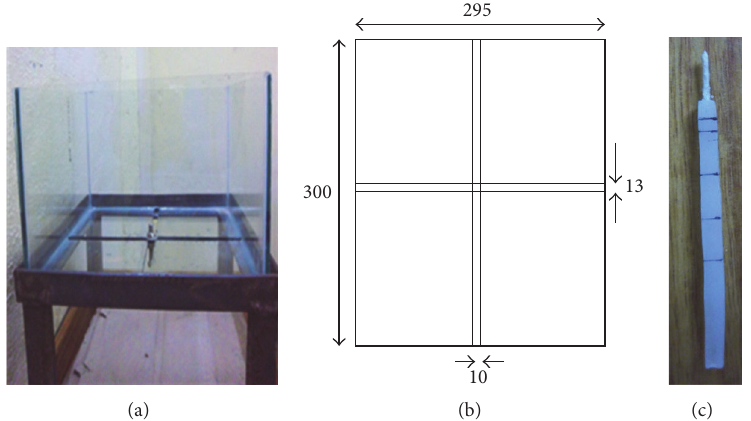
Figure 3: Experimental setup: (a) side view and (b) schematic (all dimensions are in mm); (c) marked candle (external flaming source).